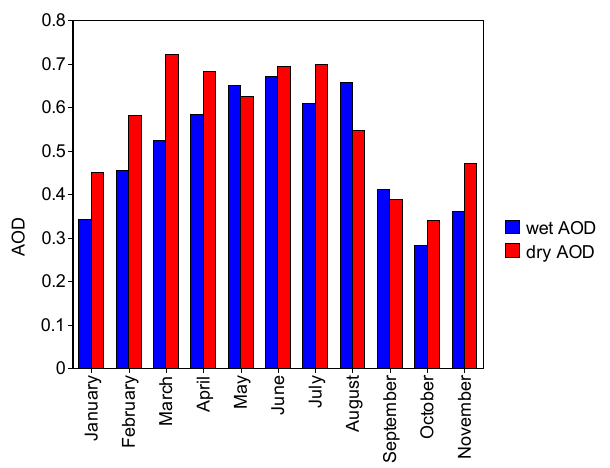
Fig. 8. Mean monthly AOD values (at 320nm from Brewer#016) for dry and wet days for a time period from 1984 to 2009.